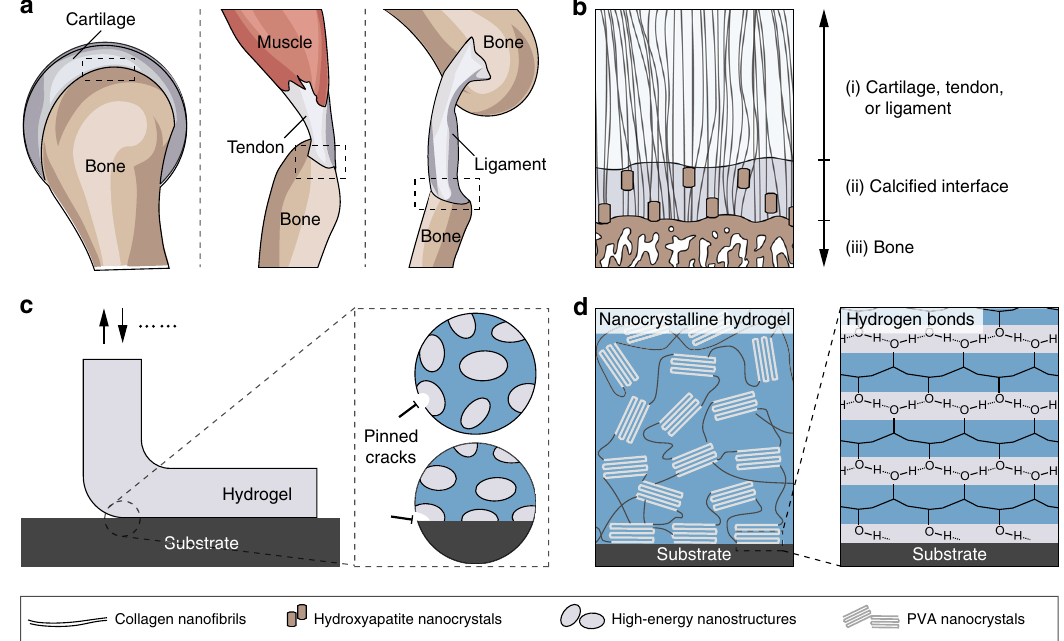
Fig. 1 Bioinspired design of fatigue-resistant hydrogel adhesion. a Schematic illustration of the fatigue-resistant adhesions between soft connective tissues (cartilage, tendon, and ligament) and bones. b The transitional interface from uncalci fi ed collagen nano fi brils (i) to calci fi ed nano fi bers (ii) to the bone (iii). The nanostructured composites of aligned collagen nano fi brils and ordered hydroxyapatite nanocrystals contribute to the fatigue-resistant adhesions of the cartilages, tendons, and ligaments to the bones. c Bioinspired fatigue-resistant adhesion of synthetic hydrogels by anchoring ordered high- energy nanostructures (e.g., nanocrystalline domains) on engineering materials. These high-energy nanostructures (e.g., nanocrystalline domains) can effectively pin the crack propagation both at the interface and within the bulk hydrogels, since they require a much higher energy for fatigue-crack propagation than the corresponding amorphous polymer chains. d Fatigue-resistant adhesion of poly(vinyl alcohol) (PVA) hydrogel to substrates through the anchorage of ordered nanocrystalline domains on the substrates with hydrogen